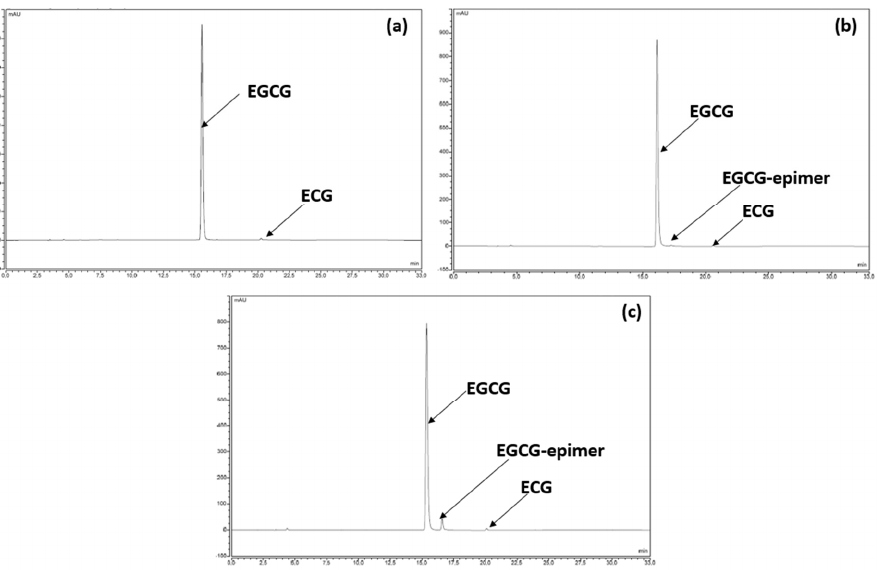
Figure 4. ( a ) Chromatographic profile of the formulation at time 0. ( b ) Chromatographic profile of the formulation after 18 months under standard conditions. ( c ) Chromatographic profile of the formulation after 6 months under accelerated conditions.